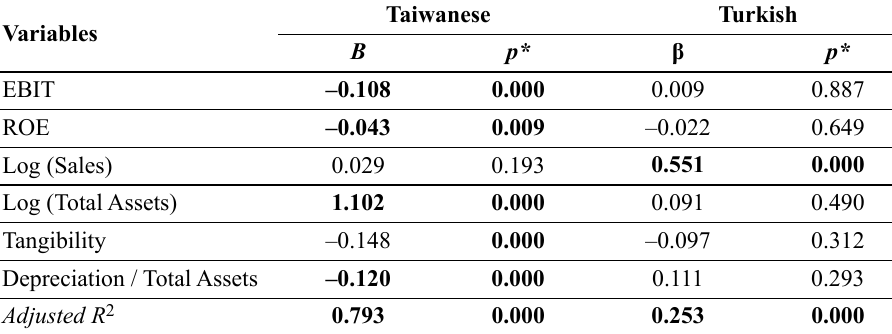
Table 5. Effects on the Short-term Debts / Total Assets ratio (SD / TA) Variables